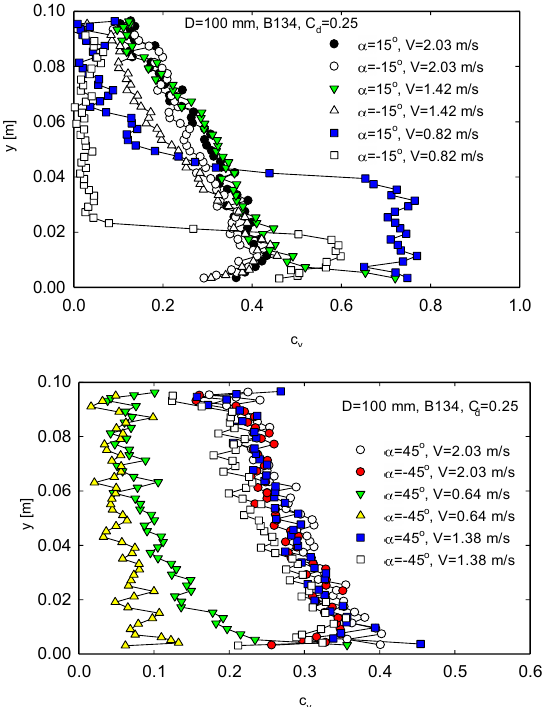
Fig. 8. Effect of mean slurry velocity V on local concentration profiles ( C d = 0.25).